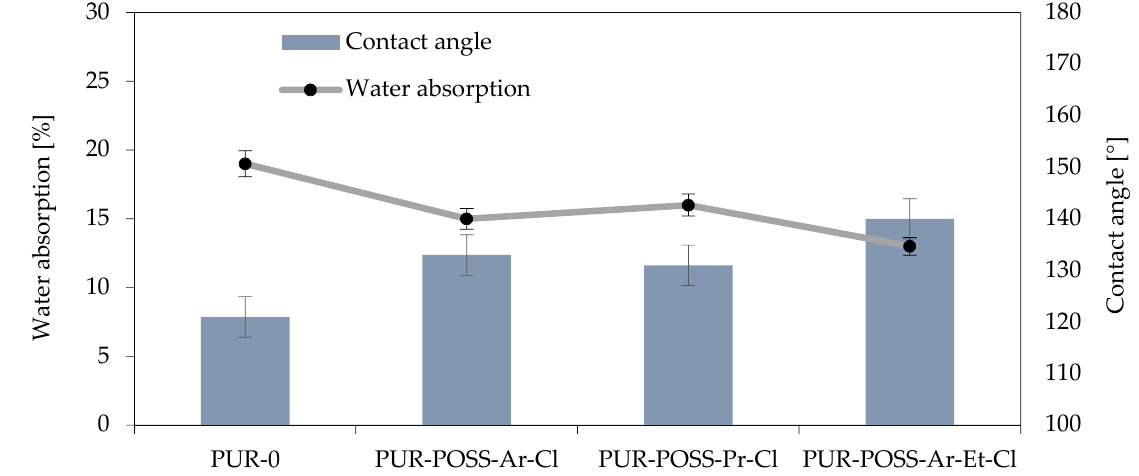
Figure 5. Effect of contact angle on water absorption of RPUFs modified with POSS-Cl.